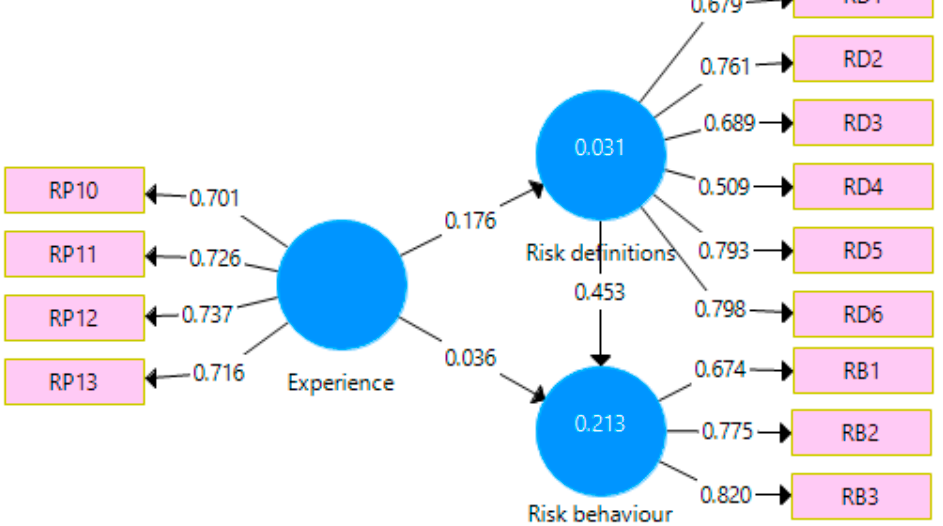
Figure 4. Model Three Structural Path Graph (Source: Authors’ Compilation).